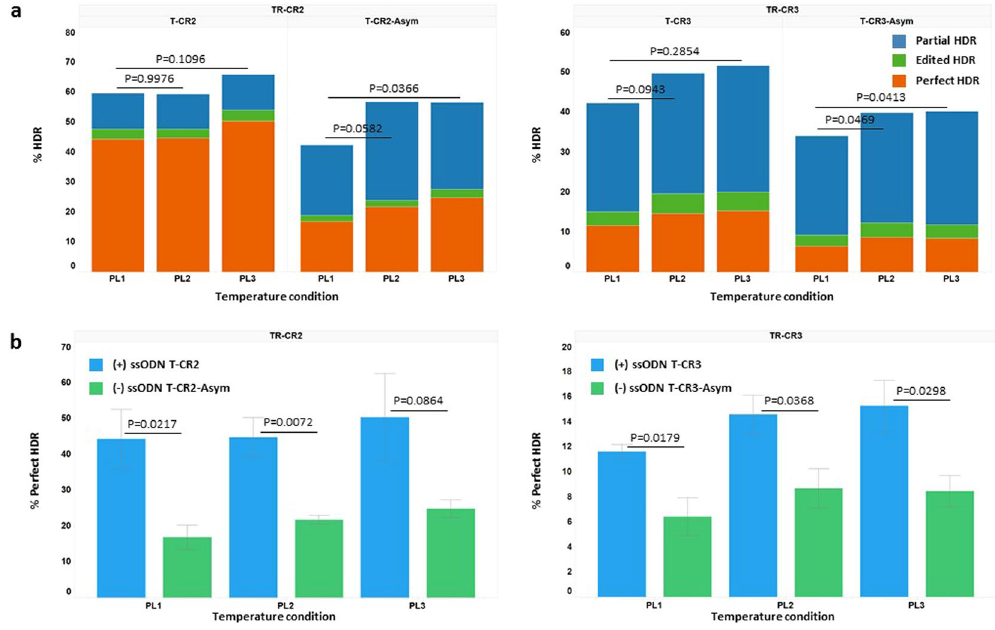
Figure 5. Effects of ‘cold shock’ and ssODN HDR donor designs on HDR efficiency at the TGFBR1 locus in mc-iPSCs. ssODN HDR donors and sgRNAs were co-delivered into mc-iPSCs cells along with Cas9 mRNA to achieve HDR at the TGFBR1 locus. Experiments were carried out at different temperatures over 24 hour intervals as described in “material and methods”: PL1: 37 °C-37 °C-37 °C, PL2: 37 °C-32 °C-37 °C, PL3: 37 °C-32 °C-32 °C. ( a ) HDR events using 10 pmol of ssODN HDR donors for each treatment (TR-CR2 with T-TR2 or T-TR2-Asym, TR-CR3 with T-TR3 or T-TR3-Asym) were determined by NGS as described in “material and methods”. The data presented are the mean percentage HDR events (4 biological replicates from three independent experiments). The HDR types were categorized into three groups based on the resulting sequence around the region of the intended mutations. ‘Perfect HDR’: All intended base changes are present with no re-editing indels. Edited HDR: One or more of the intended base changes are present with re-editing indels. Partial HDR: Some but not all of the intended base changes with no indels. The significance of total HDR efficiencies differences among the three temperature conditions for each sgRNA and ssODN treatment were analyzed by one way ANOVA (one way ANOVA: TR-CR2 with T-TR2, P = 0.4037; TR-CR2 with T-TR2-Asym, P = 0.0208; TR-CR3 with T-TR3, P = 0.1846; TR-CR3 with T-TR3-Asym, P = 0.0139; P value of follow-up Dunnett’s multiple comparison are shown in the figures). HDR from 30 pmol ssODN and no oligo treatment are shown in the Supplementary Table 4 ( b ) events using 10 pmol of ssODN HDR donors for each treatment (TR-CR2 with T-TR2 or T-TR2-Asym, TR-CR3 with T-TR3 or T-TR3-Asym) were plotted to compare ‘perfect HDR’ frequencies between the two ssODN designs. Data presented are the mean percent of ‘perfect HDR’ events ± SEM (4 biological replicates from three independent experiments). The difference of ‘perfect HDR’ frequencies between the two ssODN designs in each treatment group were evaluated by Student’s T-test and p values are shown in the figures. Across all temperature conditions, ( + ) ssODN strand T-CR2 and T-CR3 promote more ‘perfect HDR’ than ( − ) ssODN strand T-CR2-Asym and T-CR3-Asym,